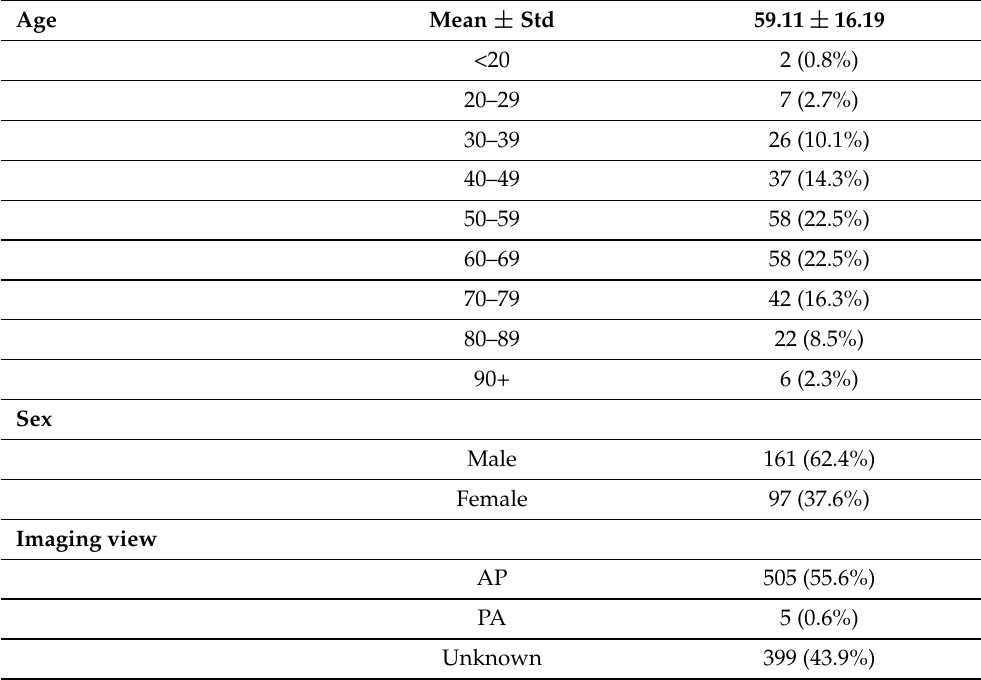
Table 2. Summary of demographic variables and imaging protocol variables of CXR data in the dataset used in this study. Age and sex statistics are expressed on a patient level, while imaging view statistics are expressed on an image